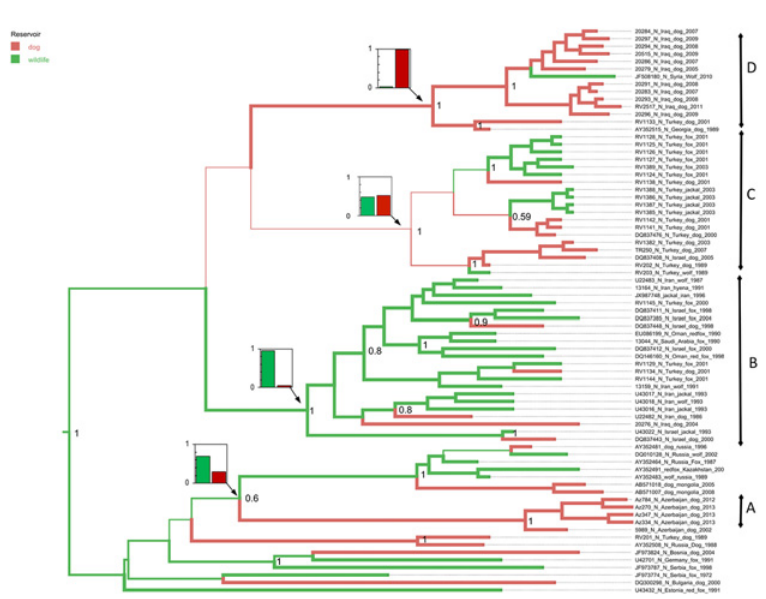
Fig 3. Maximum clade credibility tree using host species as a discrete trait, using only sequences from viruses detected in wild canids or dogs. Branches are coloured by the most probable host species (dogs or wildlife) of the progeny node, with inset plots of relative probability at key